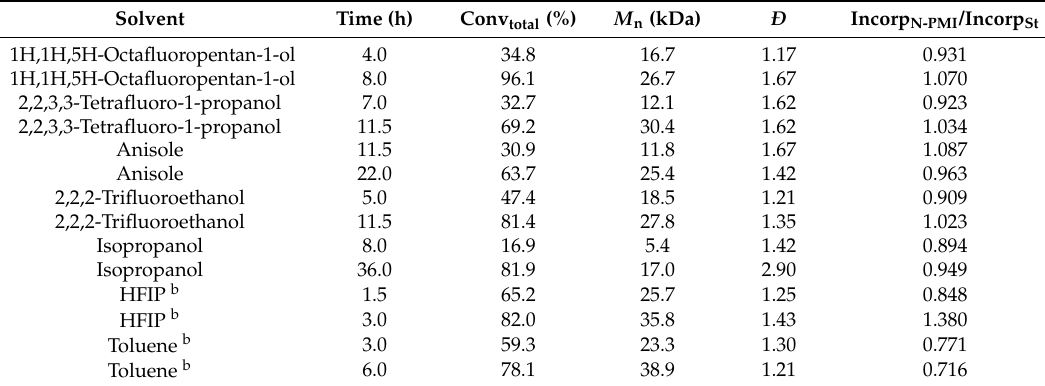
Table 1. RAFT polymerization of N-PMI and St in different solvents a